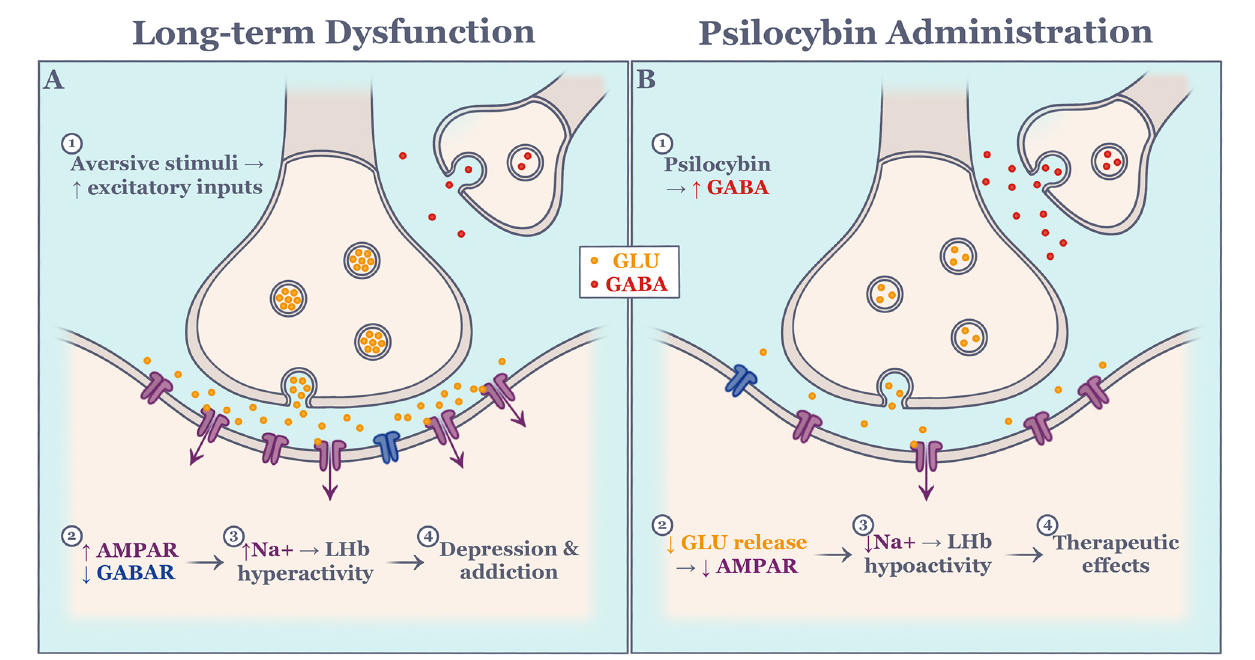
FIGURE 3 | Schematic of hypothesized molecular effect on excitatory lateral habenula neurons during long-term dysfunction (A) and psilocybin administration (B) . Events are numbered in succession. AMPAR, alpha-amino-3-hydroxy-5-methyl-4-isoxazole propionic acid receptor; GABA, gamma-aminobutyric acid; GABAR, gamma-aminobutyric acid receptor; GLU, glutamate; LHb, lateral habenula; Na,